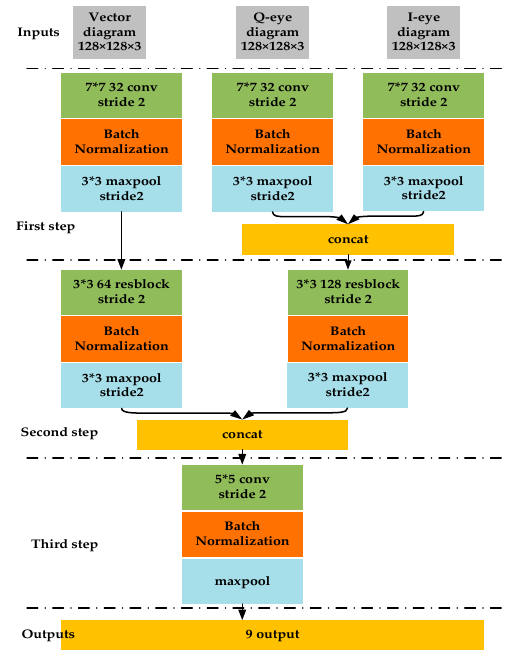
Figure 7. The network model for signal modulation recognition.